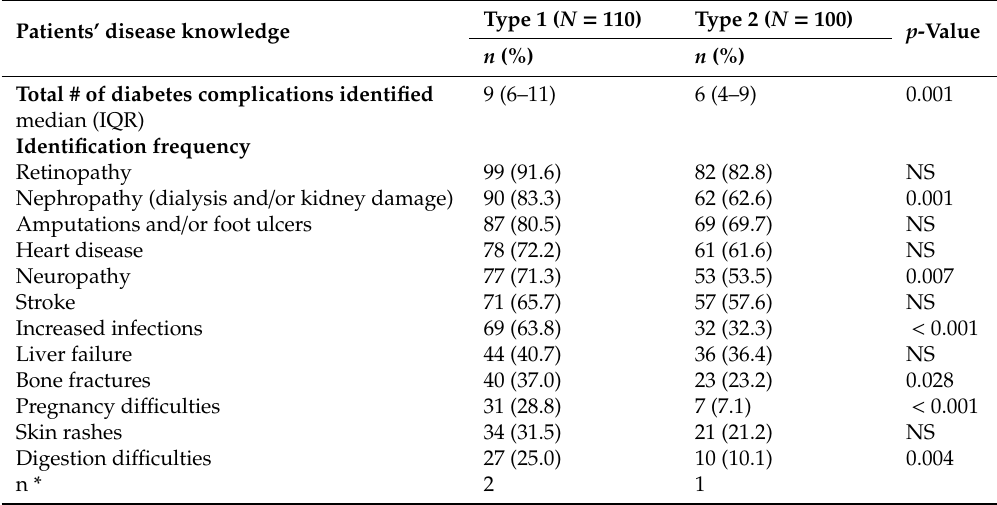
Table 3. Respondents’ identification of potential diabetes-related health